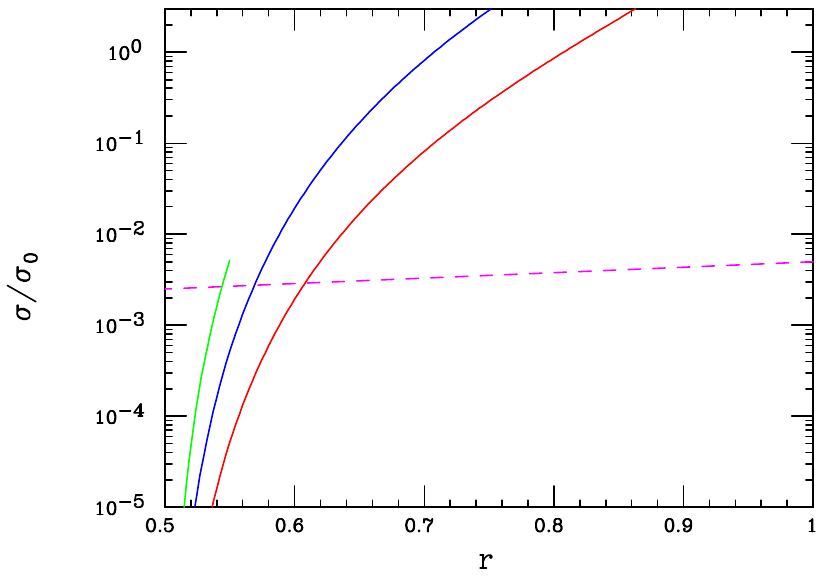
Figure 8 . Same as the previous figure but now assuming that δ = 0 . 25 . Again the perturbativity constraint on g D is playing a role here when (cid:15) = 10 − 4